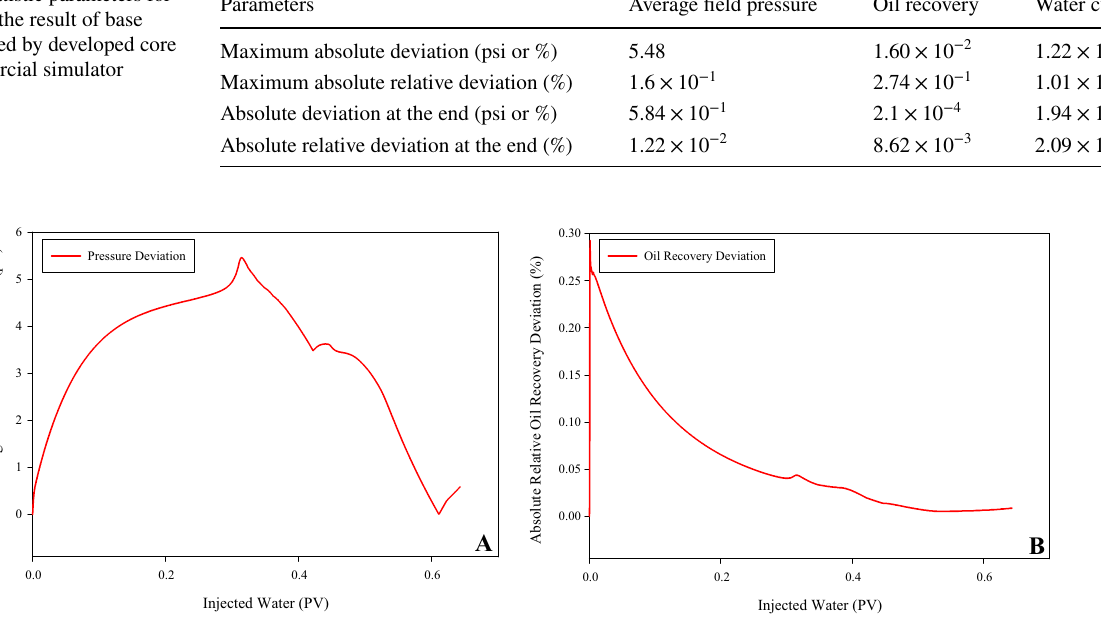
Fig. 5 Comparison of absolute deviation of a average field pressure, and b oil recovery between the developed code and the commercial simula-